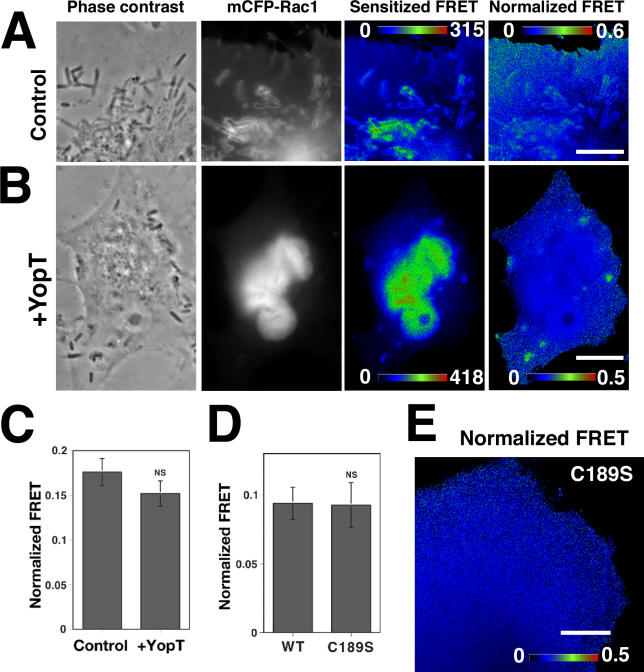
YopT Cleavage Does Not Prevent Rac1 ActivationCOS1 cells were cotransfected with plasmids expressing mYFP-PBD and either mCFP-Rac1 or mCFP-Rac1C189S followed by exposure to Y. pseudotuberculosis for 30 min (Materials and Methods) and FRET analysis in cytoplasmic ROIs.(A–C) Cells expressing mCFP-Rac1(WT) challenged with either YP17 (control) (A) or mCFP-Rac1(WT) challenged with YP17/pYopT (+YopT) (B). Rac1 activation is maintained in the presence of YopT cleavage (C). Data for normalized Rac1 activity from eight cells described in (A) and (B) were quantitated as mean ± SEM.(D) Cytoplasmic localization of Rac1 does not affect activation. FRET was analyzed in ROIs from cytoplasmic regions of uninfected cells transfected with mCFP-Rac1(WT) or mCFP-Rac1C189S and normalized versus amount of mCFP observed in each cell. NS, no significant difference between control and experimental.(E) Example of normalized FRET observed in uninfected cell expressing mCFP-Rac1C189S. White bar represents 10 μm.